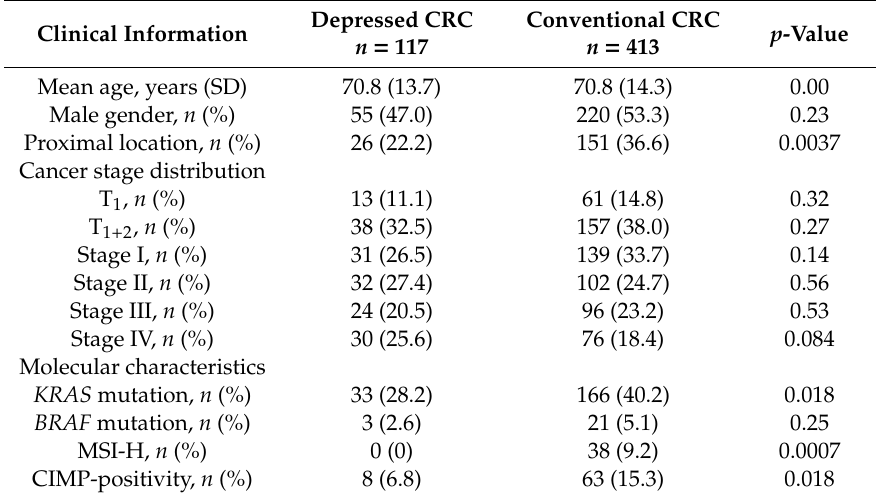
Table 2. Comparison of depressed colorectal cancer (CRC) with conventional